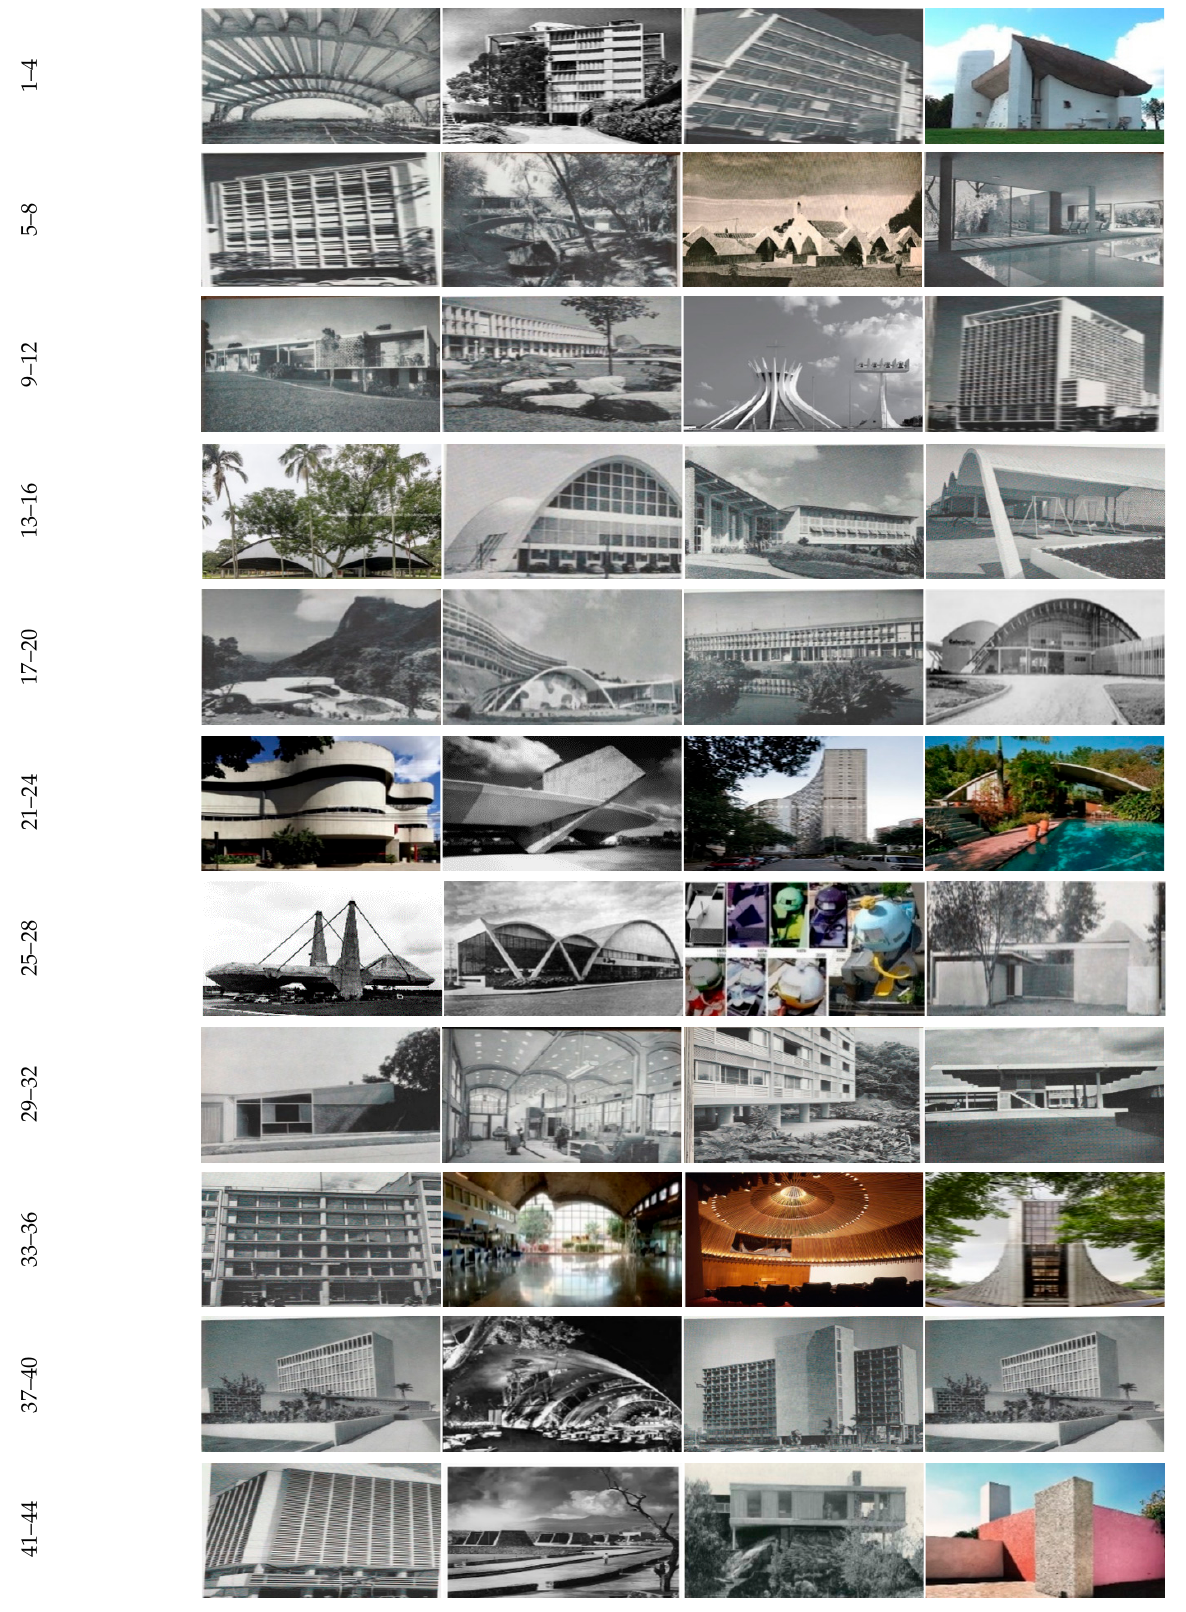
Table 2. Sample projects of designers (row numbers are matched with Table 1).